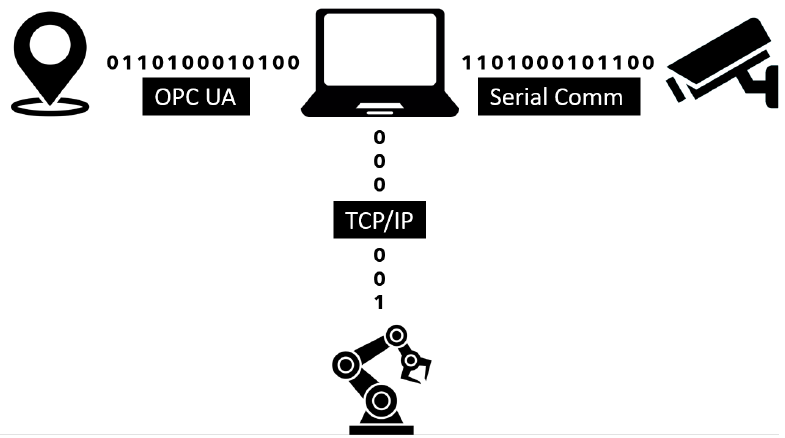
Figure 5. Architecture of the test